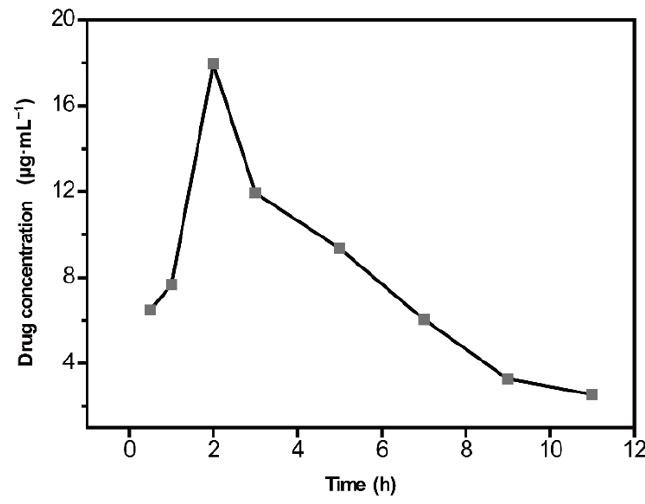
Figure 6. Average serum concentration–time curve of carbamazepine (CBZ).